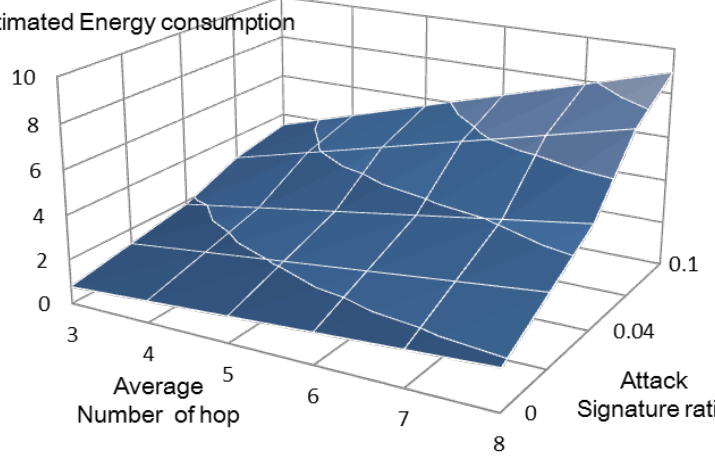
Figure 7. Estimated energy consumption of the previous method.